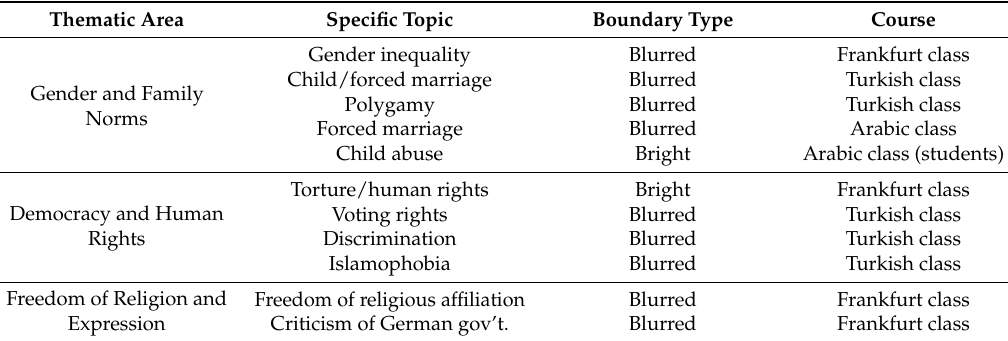
Table 2. Immigrant/German boundary drawing in integration